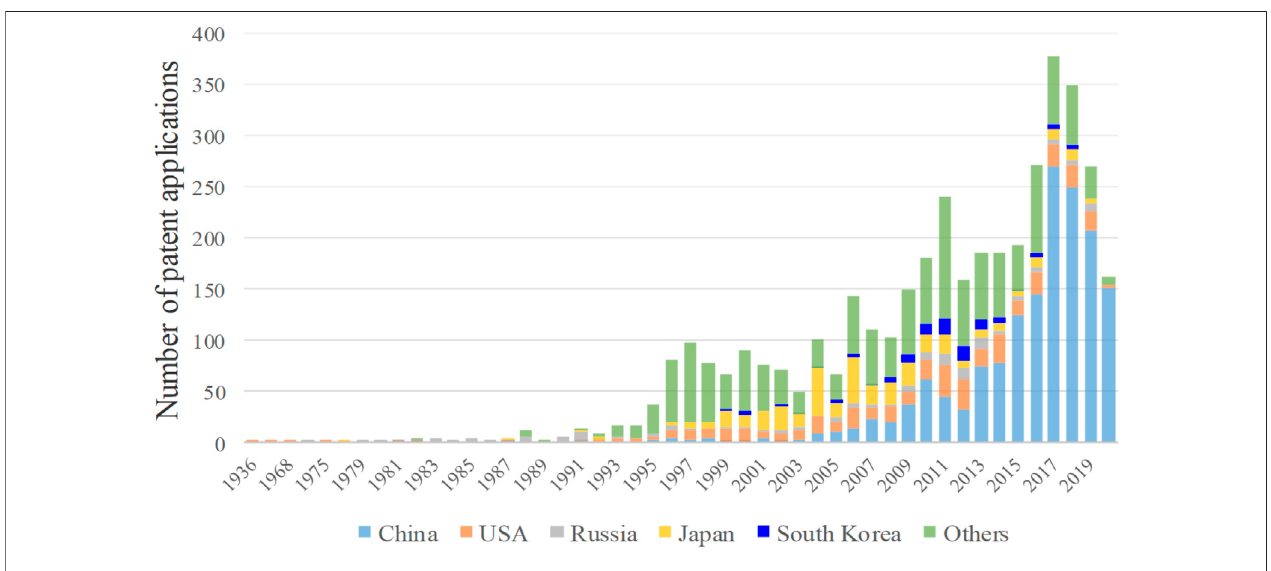
FIGURE 1 | Patent application trend of gas hydrate in major countries in the